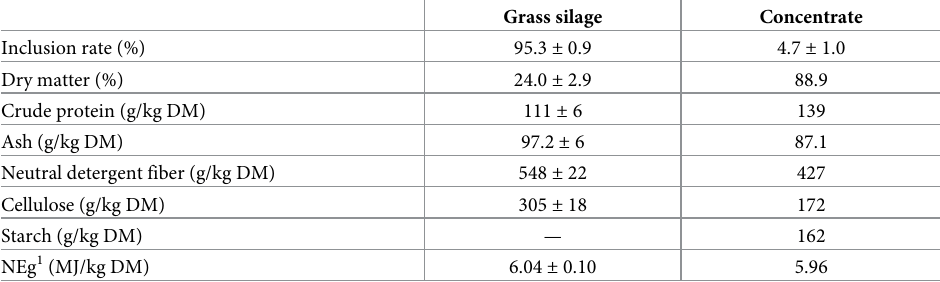
Table 1. Chemical composition and energy content of the experimental feed (mean ±